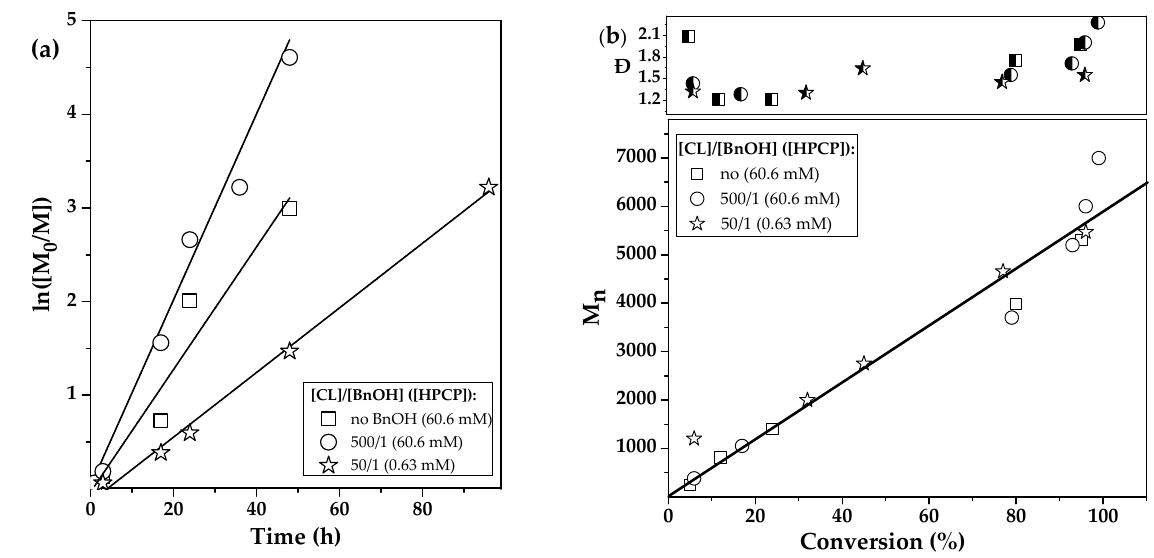
Figure 2. ( a ) ln([M] 0 /[M]) versus time and ( b ) M n versus conversion plots for the bulk polymerization of ε -caprolactone initiated by BnOH at different [CL]/[BnOH] ratios in the presence of different amounts of HPCP at 150 °C. Initiator (BnOH) concentrations: 176 mM or 17.6 mM at [CL]/[BnOH] = 50 or 500, respectively. The straight line in ( b ) corresponds to theoretical M n for [CL]/[BnOH] = 50.